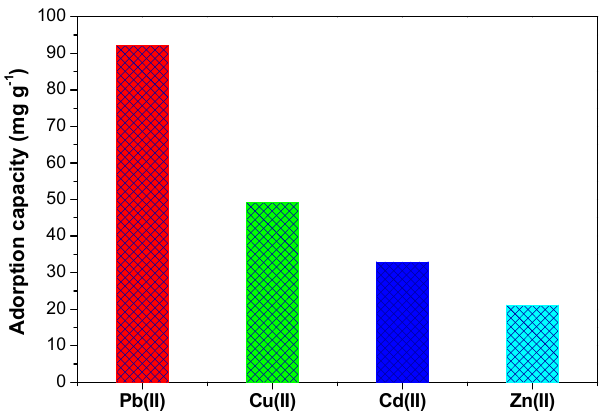
Figure 10. Effect of foreign metal ions on the extraction of Pb(II) with SiTF 5 PP (contact time: 25 min, pH = 6, T = 25 ◦ C. Adsorption dose: V = 10 mL, m = 10 mg of SiTF 5 PP at optimum concentrations: 187.36 ppm of each studied metal, Pb(II), Cu(II), Cd(II), and